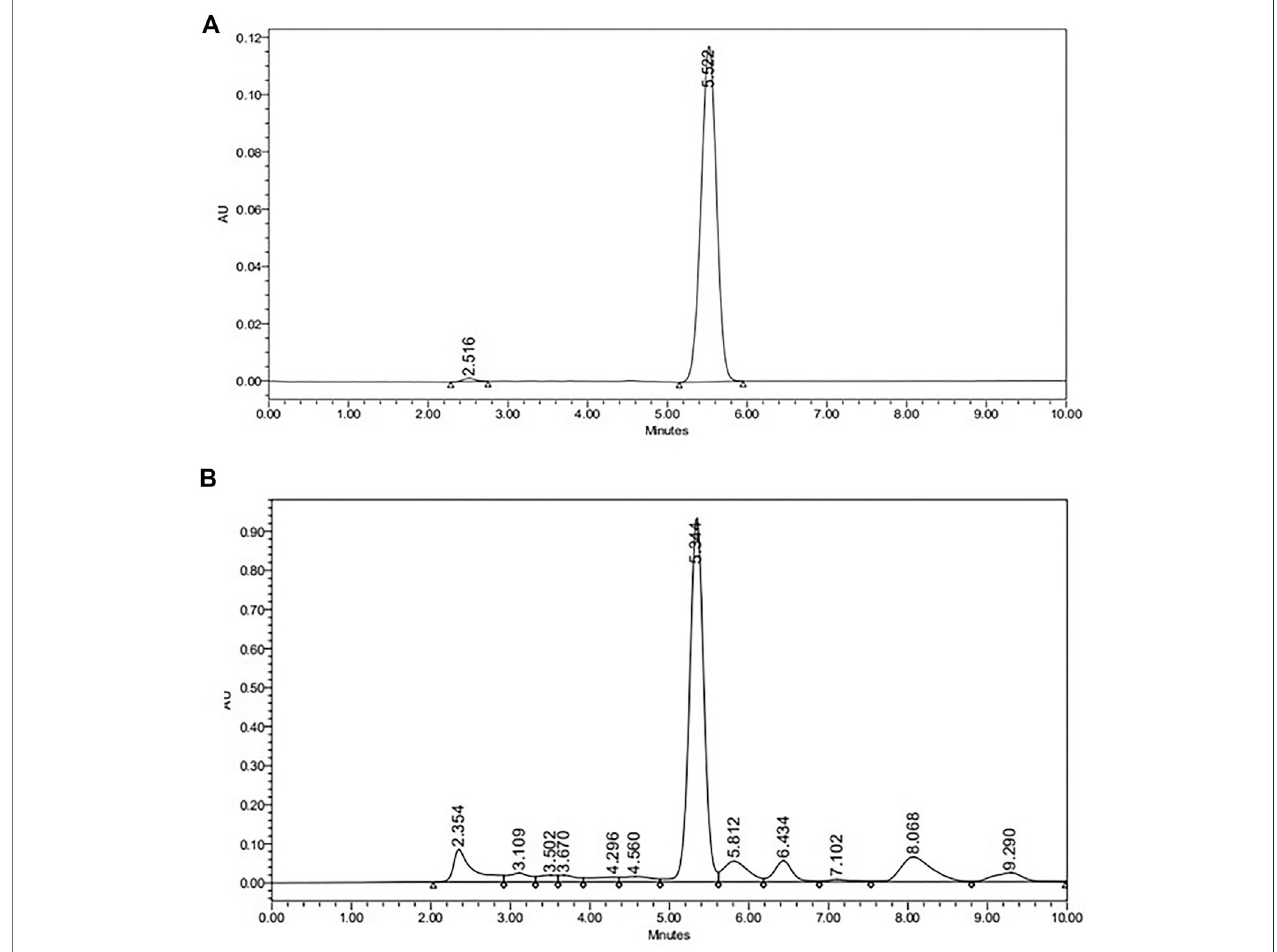
FIGURE 1 | HPLC chromatogram of (A) Andragrapholides Standard (B) Andrographis paniculata extract sample.